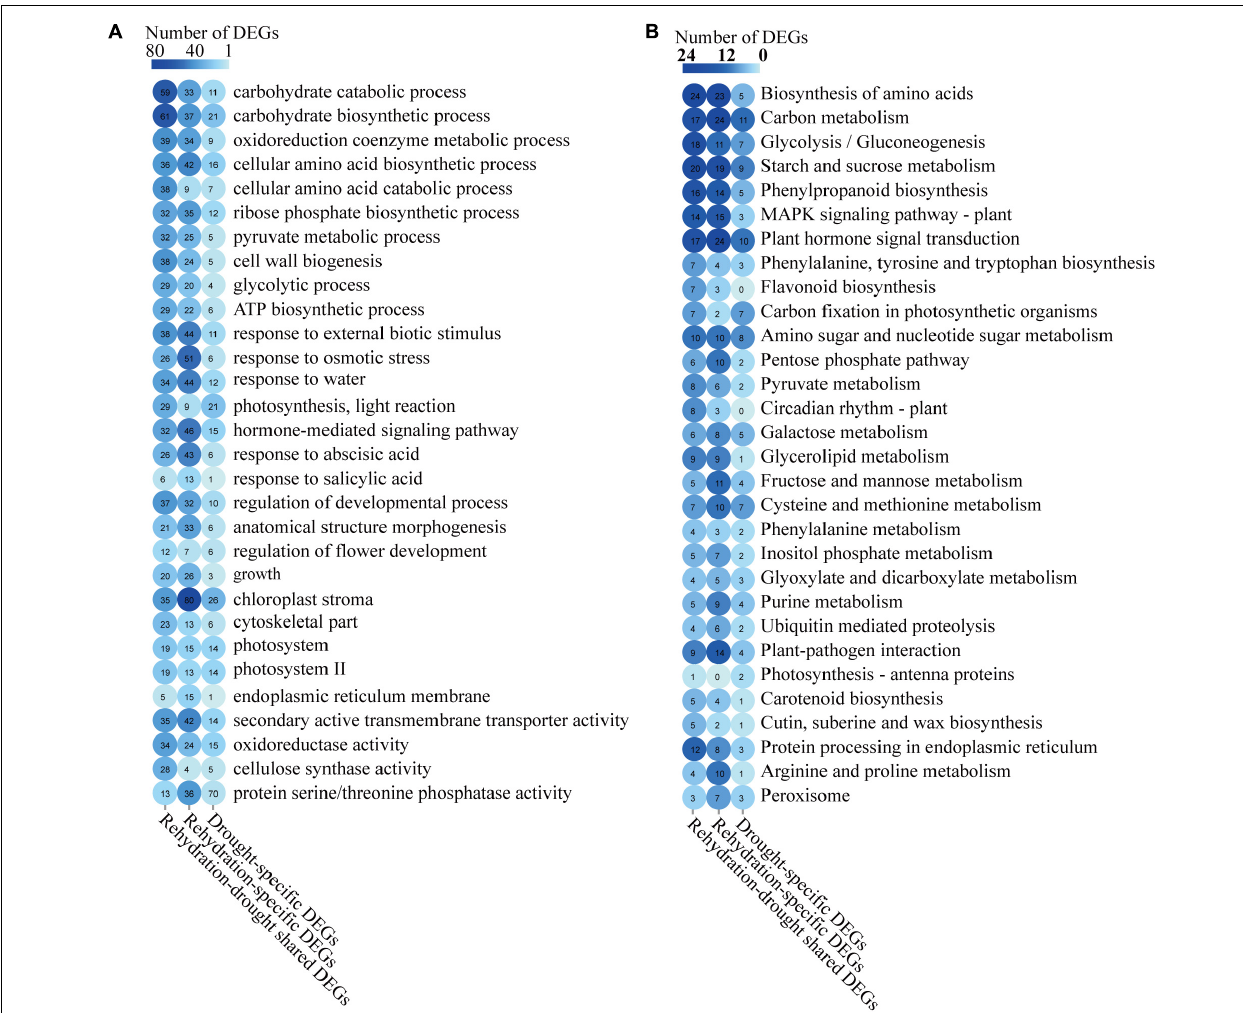
FIGURE 6 | GO and KEGG annotations of the rehydration-drought shared, rehydration-specific, and drought-specific DEGs. Enrichment of GO annotations (A) and KEGG pathways (B) in rehydration-drought shared, rehydration-specific, and drought-specific DEGs were summarized.